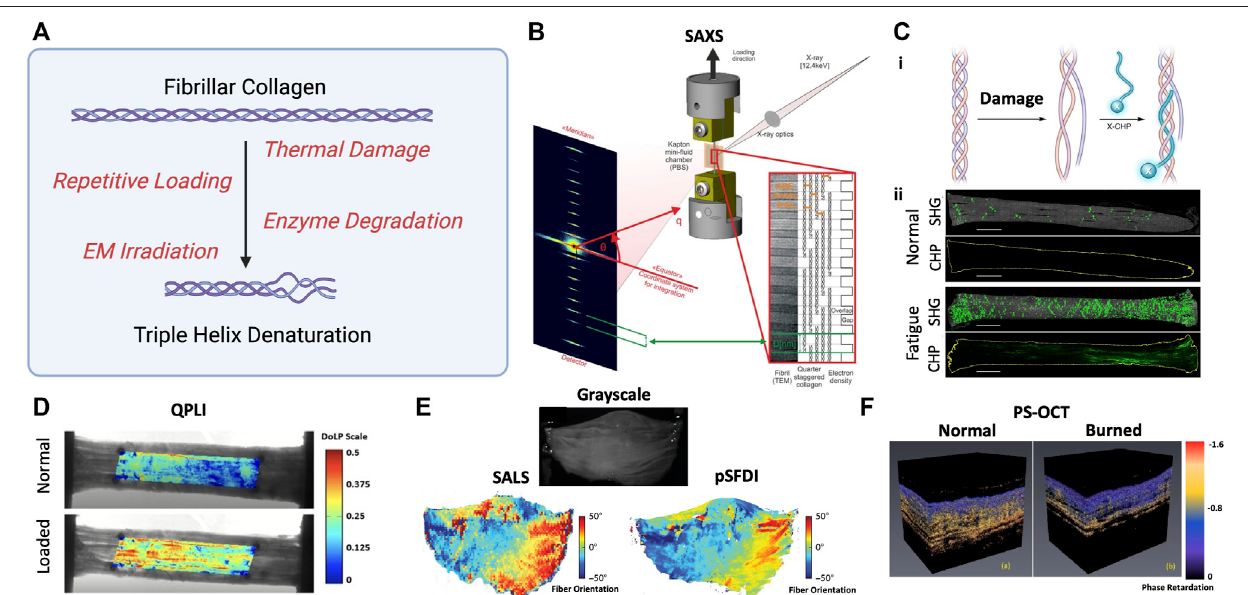
FIGURE 2 | (A) Damage to fi brillar collagen is characterized by a loss in the triple helical structure of the collagen molecule and a “ helix-to-coil ” transition. Created with BioRender.com. (B) SAXS is performed on a tendon during mechanical loading and can discern changes in the d -banding of the collagen fi bril. Reproduced with permission from Fessel et al. (2014). (C) i) Fluorescently labeled CHP forms triple helices with denatured collagen after damage. Reproduced with permission from Hwang et al. (2017a). ii) CHP staining and SHG imaging can be used simultaneously to visualize regional collagen damage due to fatigue loading via fl uorescence and fi berkinking,respectively.ReproducedwithpermissionfromSzczesnyetal.(2018). (D) TransmissionmodeQPLIcanbeusedtoquantifycollagen fi beralignmentin real time during dynamic loading. Reproduced with permission from Solon et al. (2021). (E) Both pSFDI and SALS are used to obtain fi ber alignment maps of valve lea fl ets,butpSFDIattainsahigherspatialresolutionthanSALS.ReproducedwithpermissionfromGothetal.(2016). (F) PhasemapsfromPS-OCTcandiscernbetween normal and burned skin. Reproduced with permission from Hoang et al.